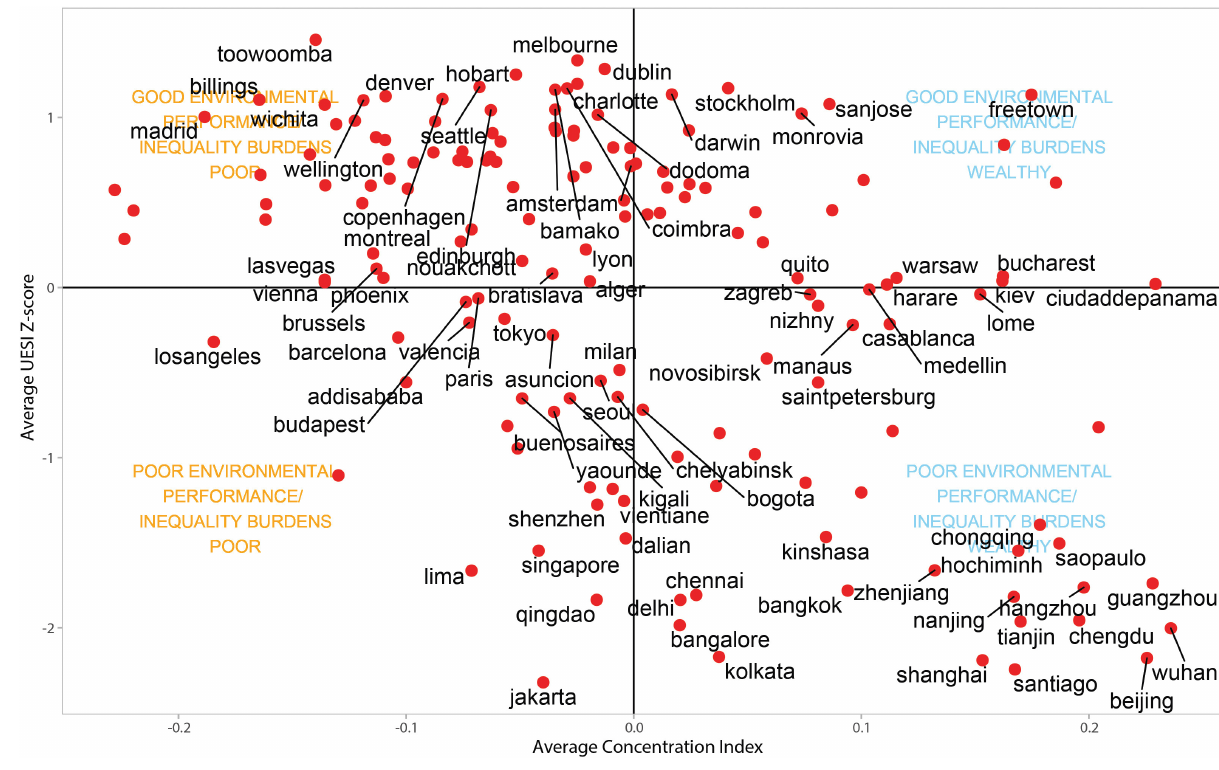
well as London, with 8.8 million people. No megacities (defined this quadrant. The mean and median population (1.7